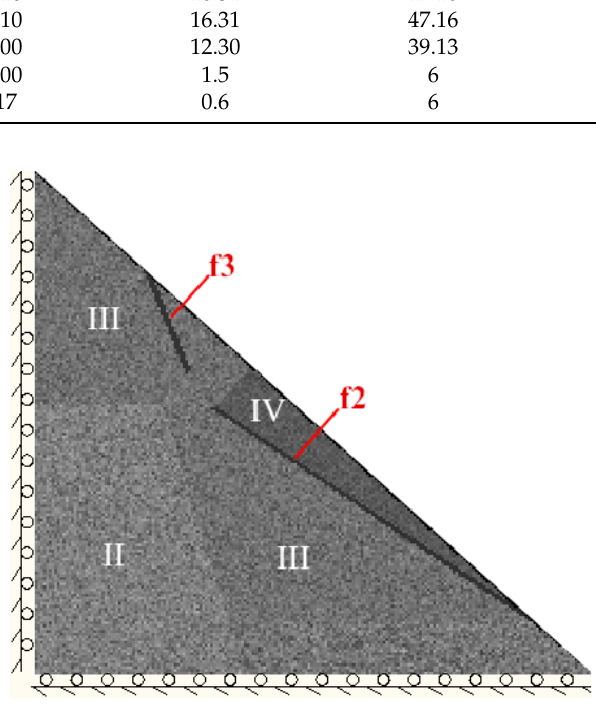
Figure 10. The numerical model for frost-heave deterioration of rock slope. II: Class II rock mass; III: class III rock mass: IV: class IV rock mass. Table 3. The thermodynamic parameters of the numerical model.